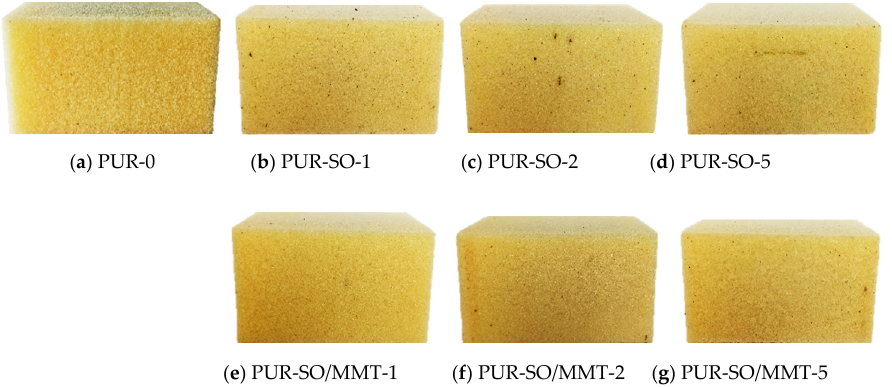
Figure 14. Optical images of PUR composites prepared in this study—( a ) PUR-0, ( b ) PUR-SO-1, ( c ) PUR-SO-2, ( d ) PUR-SO-5, ( e ) PUR-SO/MMT-1, ( f ) PUR-SO/MMT-2, ( g ) PUR-SO/MMT-5.